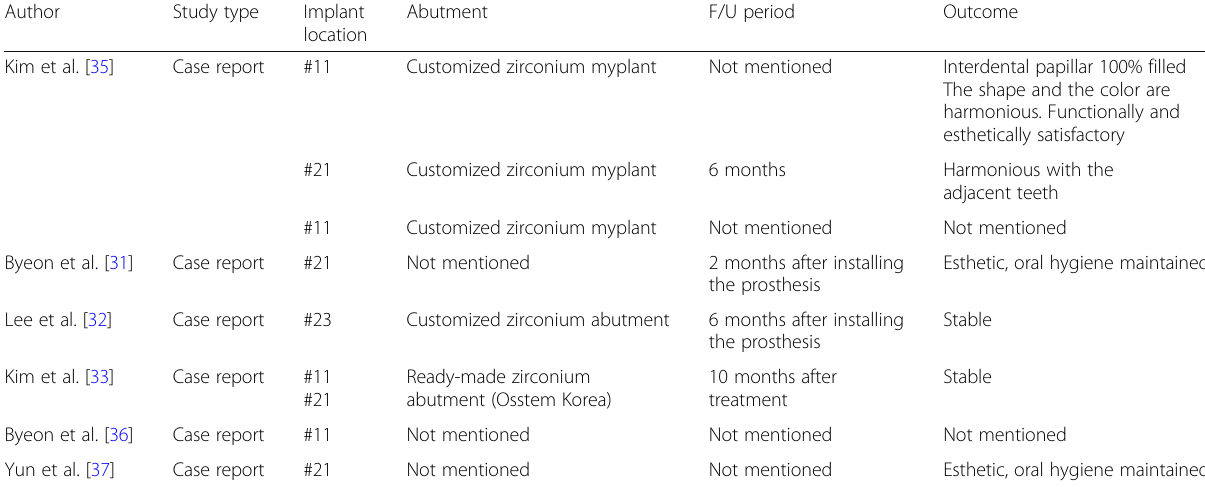
Table 4 Summary of domestic studies with evidence level 4